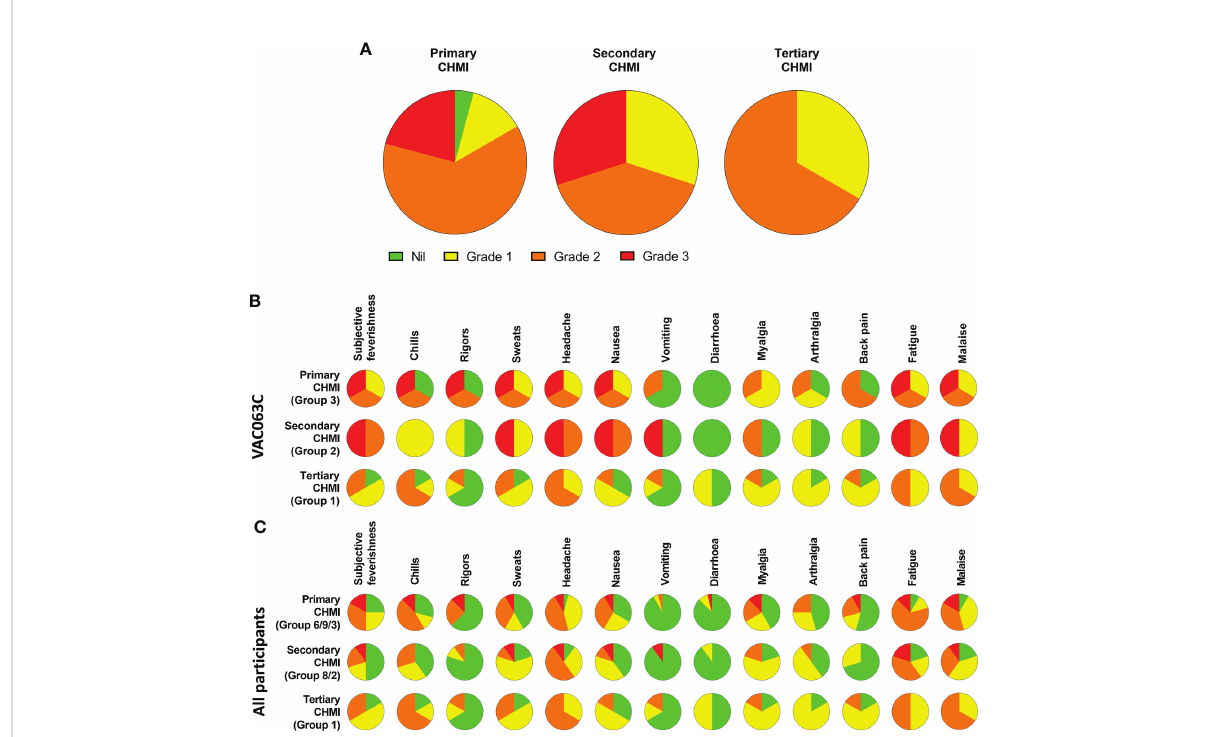
FIGURE 2 Safety of repeated P. falciparum blood-stage CHMI. Participants were asked about the presence of 13 solicited systemic adverse events (AE) at each study visit following CHMI. (A) The maximum severity of any solicited AE reported by each participant in the 48 hours before and after diagnosis during primary (n=24), secondary (n=10) and tertiary (n=6) CHMI is shown as a proportion of the total number of participants. (B) VAC063C: The solicited AEs recorded during the CHMI period are shown as the maximum severity reported by each participant and as a proportion of the participants reporting each individual AE for primary (n=3), secondary (n=2) and tertiary (n=6) CHMI. AE data was collected until 90 days after challenge. Colour coding as per panel (A, C) The solicited AEs recorded during the CHMI period are shown as the maximum severity reported by each participant and as a proportion of the participants reporting each individual AE for primary (n=24), secondary (n=10) and tertiary (n=6) CHMI for all participants across the three CHMI studies. Groups refer to speci fi c study group numbers in VAC063A, B and C. Colour coding as per panel (A)